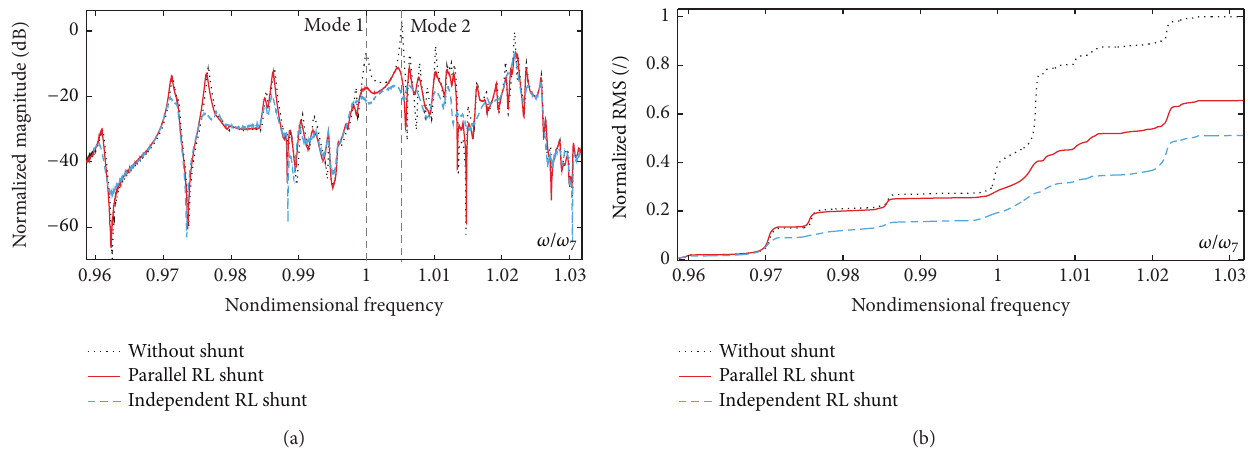
Figure 14: (a) Experimental normalized FRF 𝑇(𝜔) = | ̇𝑥/𝜂| between the appropriate excitation and the response of blade #19 in the vicinity of 𝜔 7 for various tuning conditions of the RL shunt. (b) Cumulative RMS response 𝜎(𝜔) .